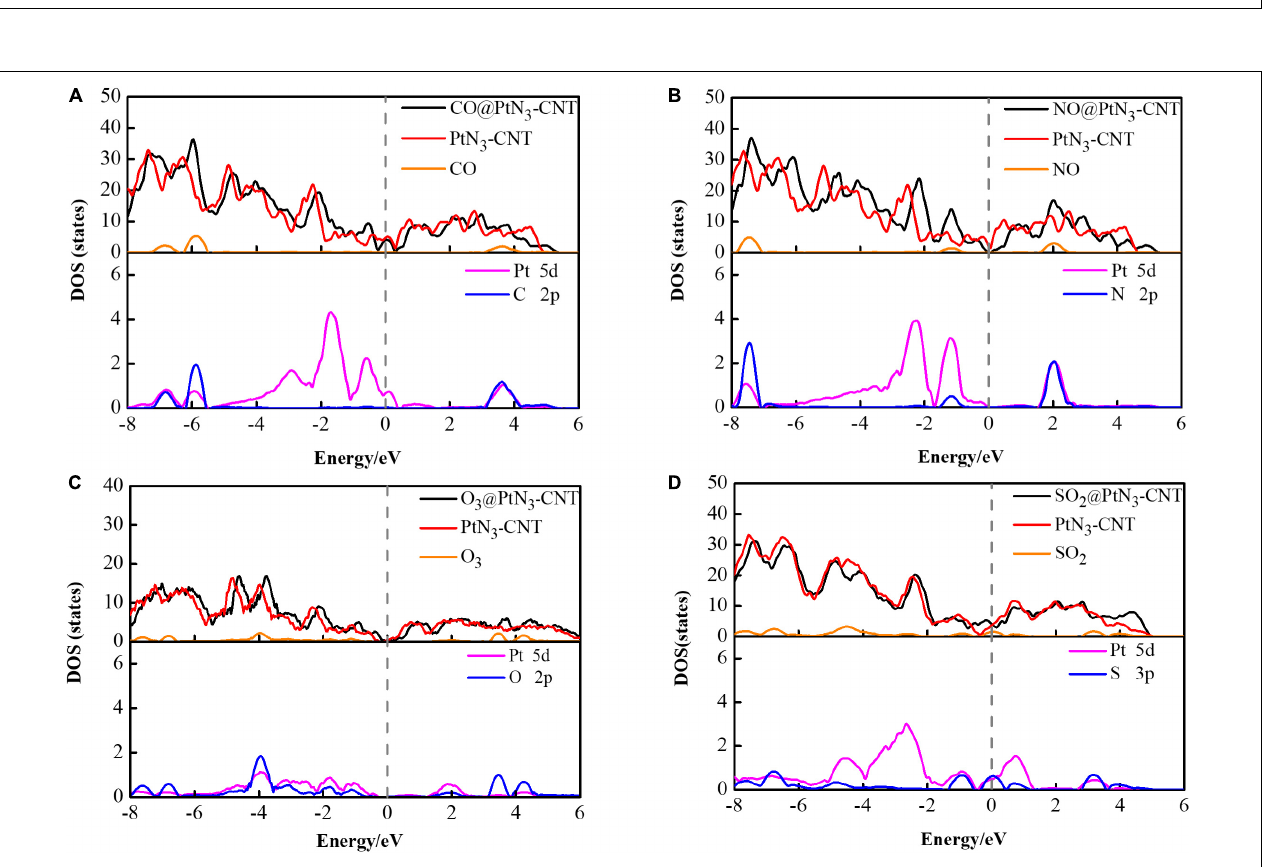
FIGURE 5 | DOS and PDOS of (A) CO@PtN 3 -CNT system; (B) NO@PtN 3 -CNT system; (C) O 3 @PtN 3 -CNT system; and (D) H 2 S@PtN 3 -CNT system. The dashed line represents the Fermi level.